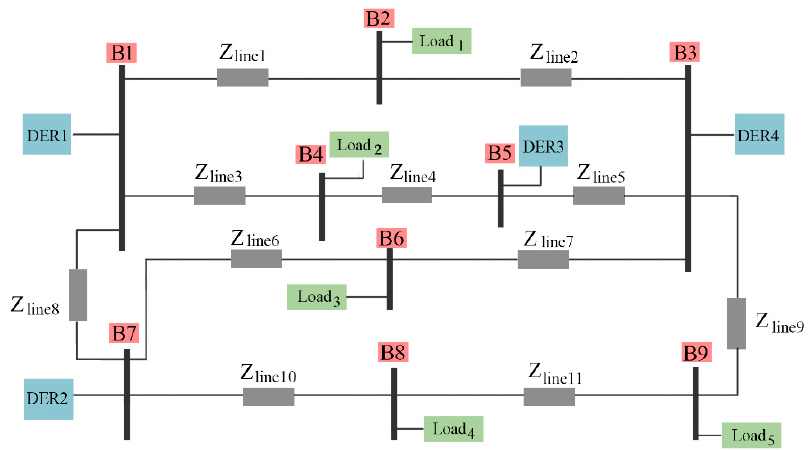
Figure 3. Schematic diagram of the test microgrid (MG).